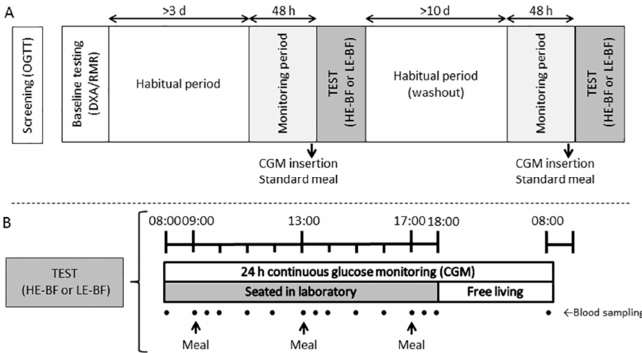
Figure 1. Study protocol: ( A ) overview of the entire study; ( B ) Overview of the trial days. Eligible participants ( n = 13) with prediabetes completed two trial conditions in a randomised order separated by >10 days. Blood was collected hourly and 30 min post each meal. Meals were provided at 09:00, 13:00 and 17:00 h in different energy distribution relative to the condition (HE-BF: 20/30/50% EI; LE-HF: 50/30/20% EI) with the same macronutrient composition in each meal (50% carbohydrate, 20% protein and 30%